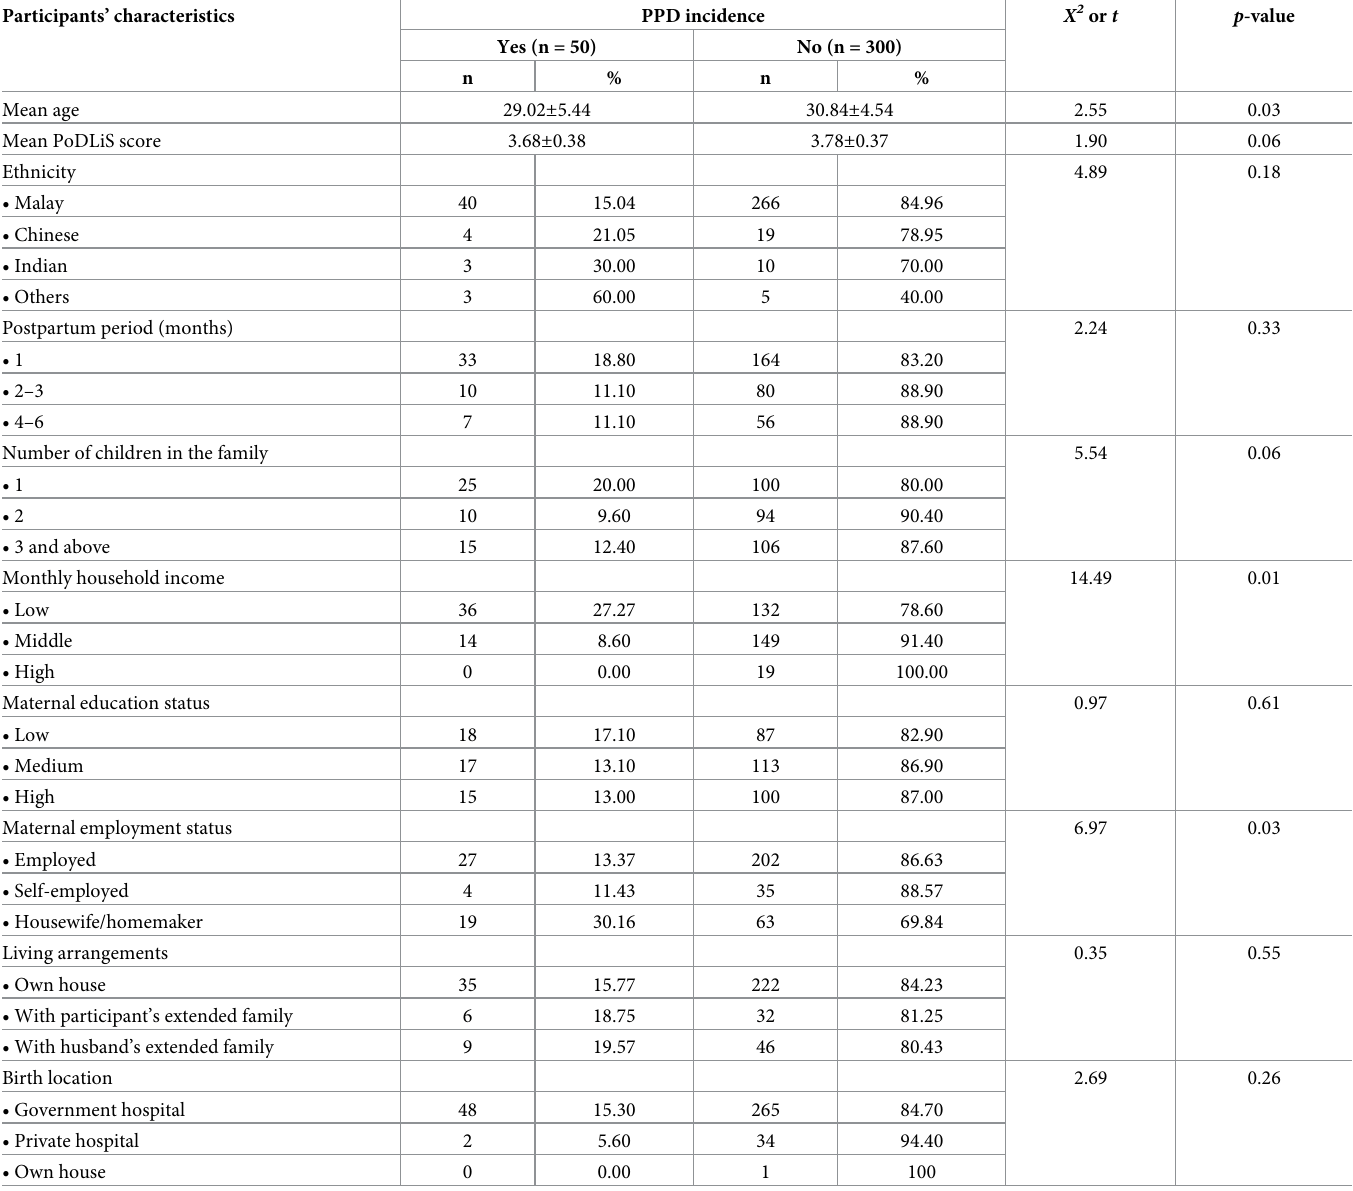
Table 2. Postpartum depression (PPD) incidence based on the study participants’ socioeconomic characteristics & PPD literacy. Participants’